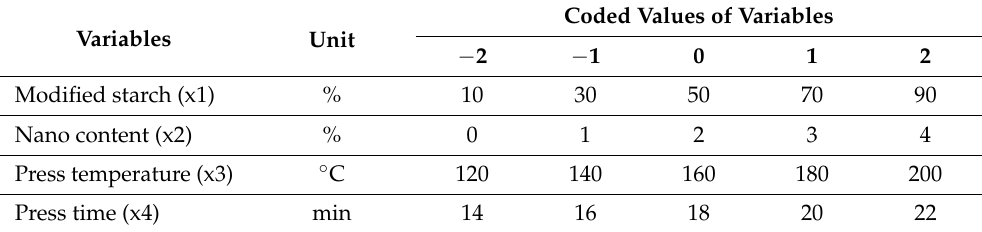
Table 1. Coded and actual levels of variables for experimental design.